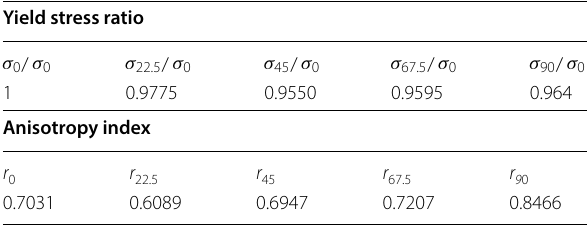
Table 1 Material constants of 5754O aluminum alloy sheet